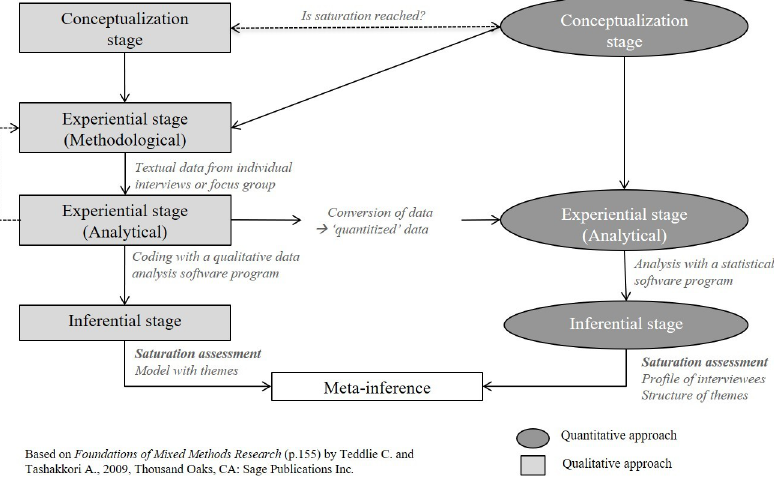
Fig 2. Graphic illustration of the conversion mixed design adapted to the question of saturation. The qualitative strand was completed prior to and independently of the present work.